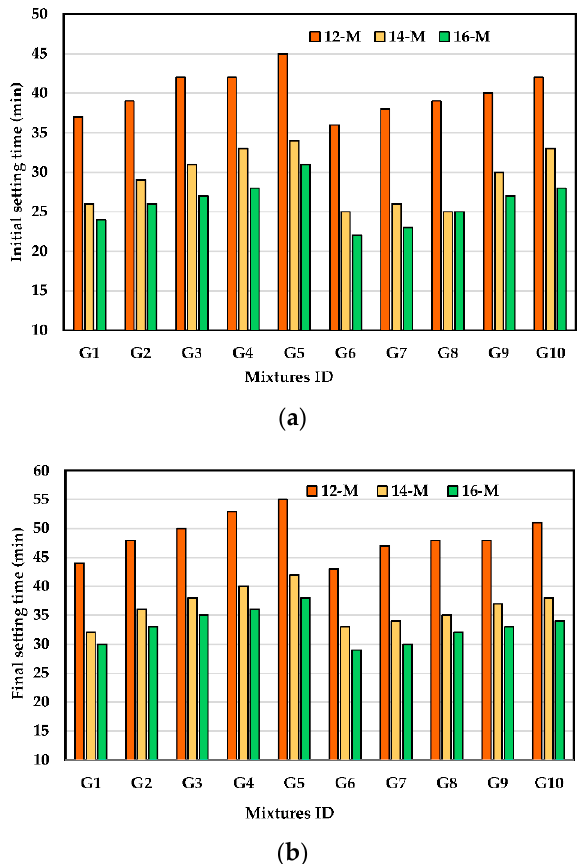
Figure 5. Effect of KOH molarity and ASM type at room temperature on ST of the UHPGC. ( a ) Initial setting time. ( b ) Final setting time. setting time. ( b ) Final setting